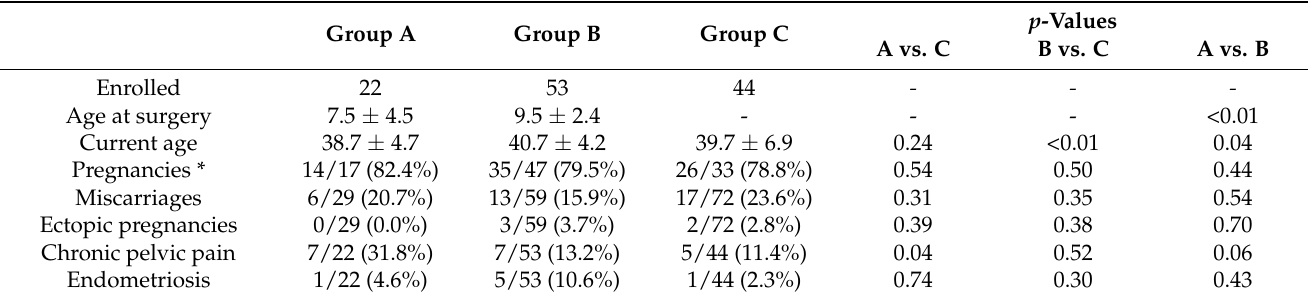
Table 1. Data of the study and p -values. Group A: complicated AA, Group B: not-complicated AA, Group C: control group; *: pregnancies in women in a stable